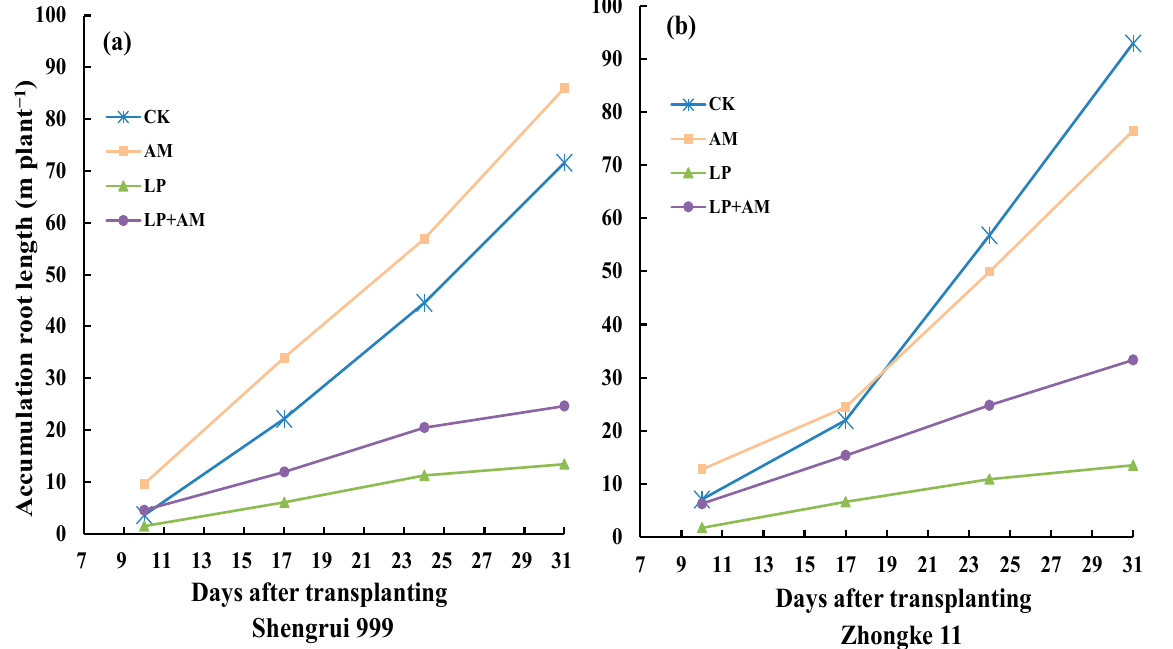
Figure 4. Accumulated visible root length (m plant − 1 ) of Shengrui 999 ( a ) and Zhongke 11 ( b ) via the transparent wall of the rhizobox on 10, 17, 24, and 31 days after transplanting (DAT) under four treatments 2.7 Correlations among morphological and physiological traits.